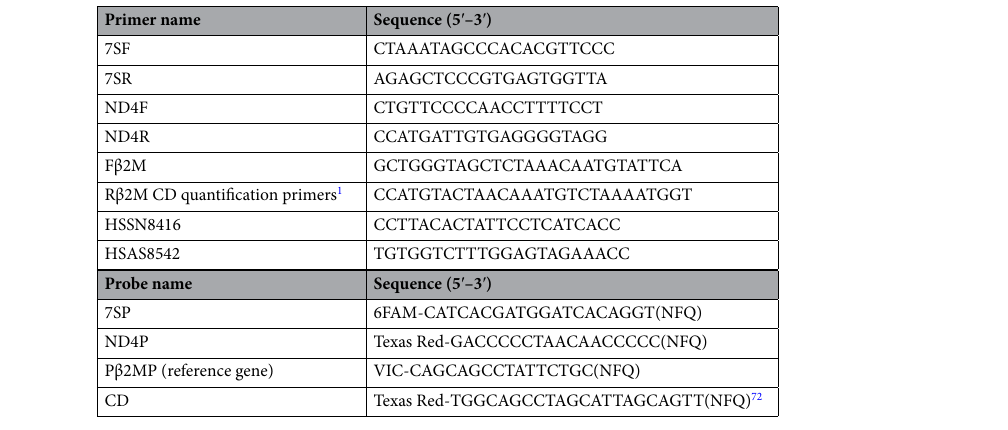
Table 4. Primers and probes used for multiplex qPCR real ‐ time